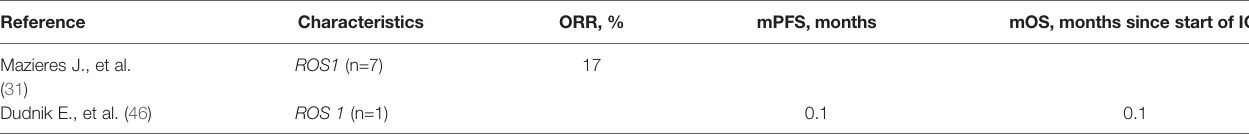
TABLE 5 | Ef fi cacy of ICIs in NSCLS with ROS-1 mutations.